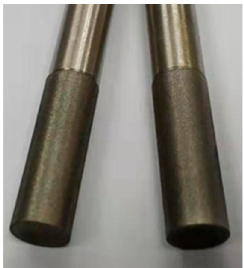
Figure 2. Electroplated cubic boron nitride (CBN) wheel.